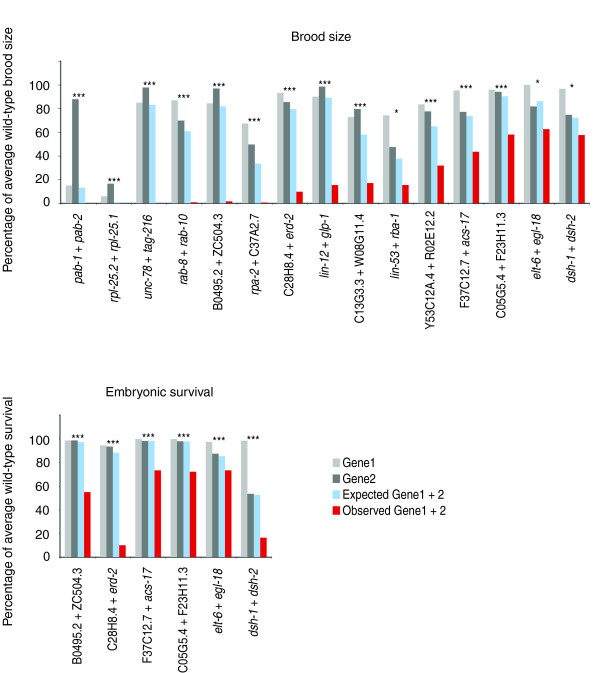
Quantitative analysis of synthetic phenotypes following the simultaneous targeting of both genes of a duplicate pair. For duplicate gene pairs that yielded reproducible synthetic effects, phenotypes produced by combinatorial RNA interference (RNAi) were quantitated. For each gene pair, brood size and embryonic survival following co-targeting of both duplicates (Observed Gene1 + 2) were compared with that following the targeting of each single gene alone (Gene1 or Gene2) and with the calculated product of the single gene brood sizes and embryonic survival measurements (Expected Gene1 + 2). Values plotted represent the percentage of average wild-type brood size and embryonic survival rates, respectively, and are the arithmetic mean of two independent experiments performed in the RNAi-hypersensitive strain rrf-3 [19]. ***p < 1.0 × 10-02, *p < 5.0 × 10-02, by Student's t-test. Note that combinatorial RNAi against the gene pair ptr-2 + ptr-10 resulted in a significantly increased number (p = 7.4 × 10-09, by Student's t-test) of first-generation larval growth arrested worms, rather than a brood size defect, hence these data are not shown.